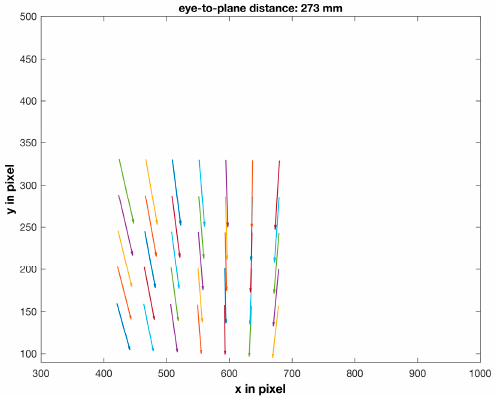
Figure A1. Map of disparities for a target plane placed at 273 mm from the observer.